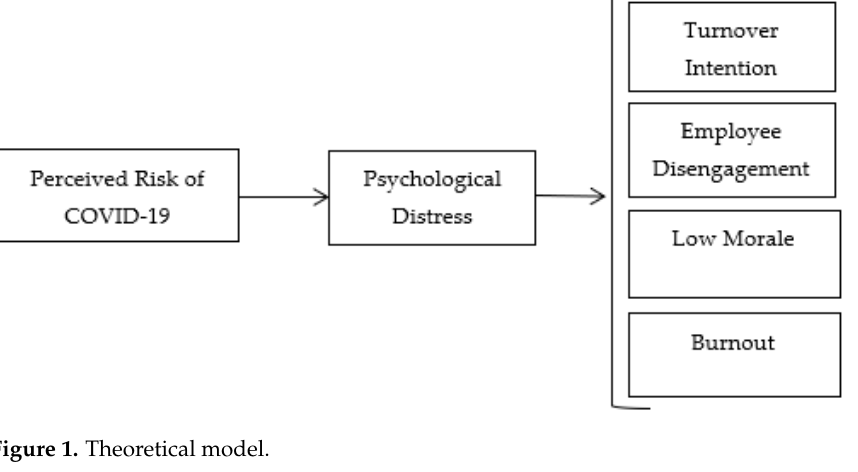
Figure 1. Theoretical model